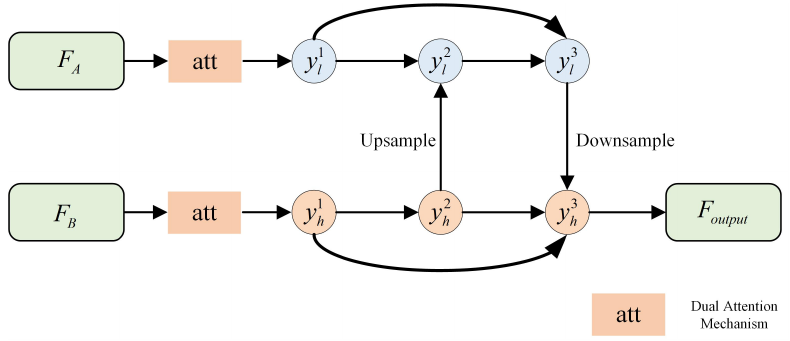
Figure 2. Bidirectional cross-feature pyramid